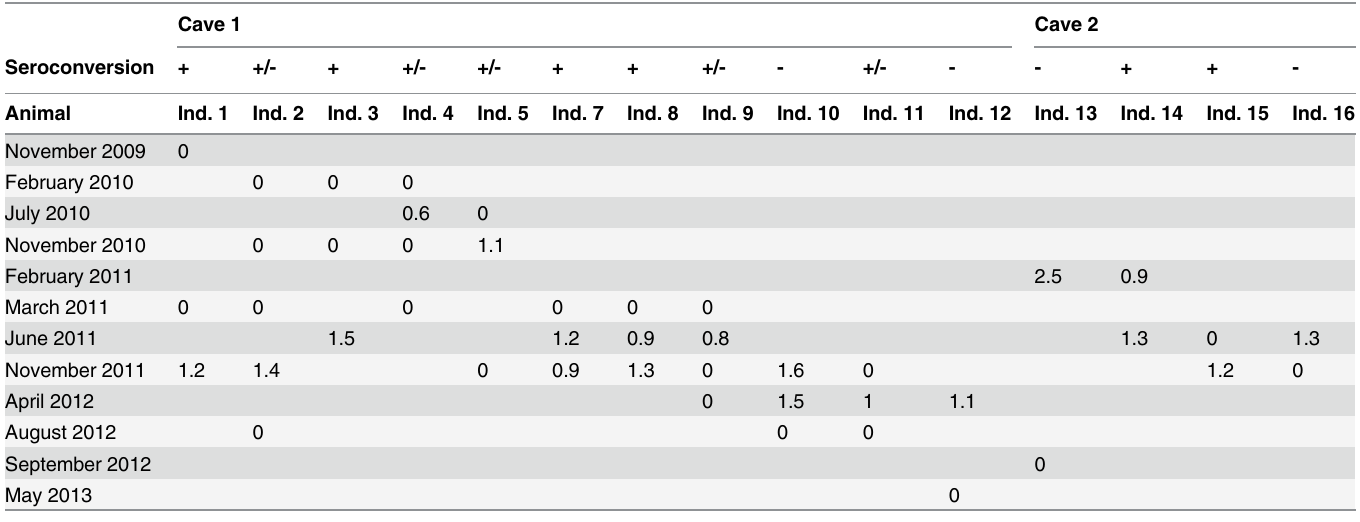
Table 2. Individual vampire seroconversion over time. Seropositivity titers are noted for each capture. Positive seroconversions are indicated by +, nega- tive seroconversions by — and positive seroconversions followed by seronegativations by +/-. Cave 1 Cave 2 Seroconversion